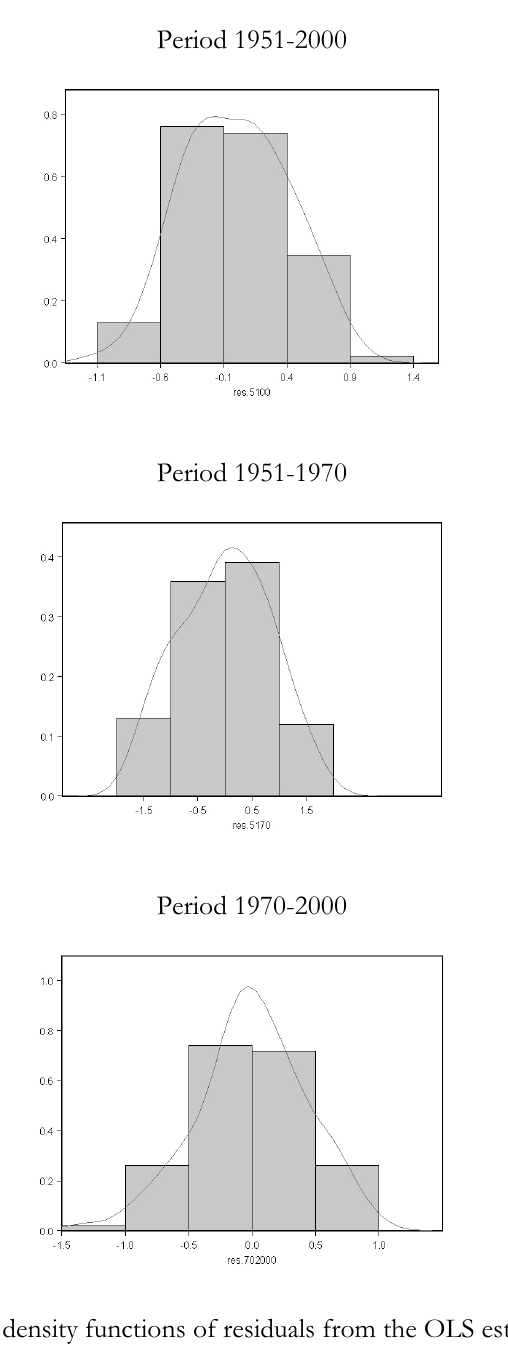
Figura 2 – Histograms and density functions of residuals from the OLS